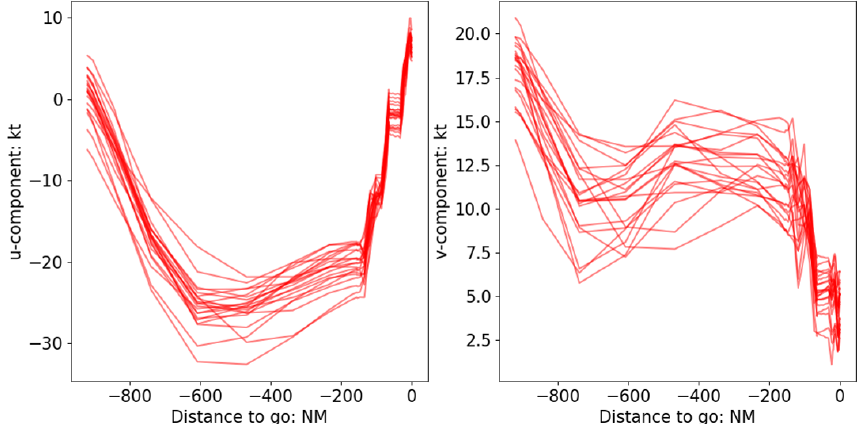
Figure 6. Lateral paths of the robust (red) and the scenario-optimal (blue) trajectories (with C I = 30 kg/min, RTA not imposed). The red dots correspond to the waypoints and the black dots show the ToD locations of the trajectories.